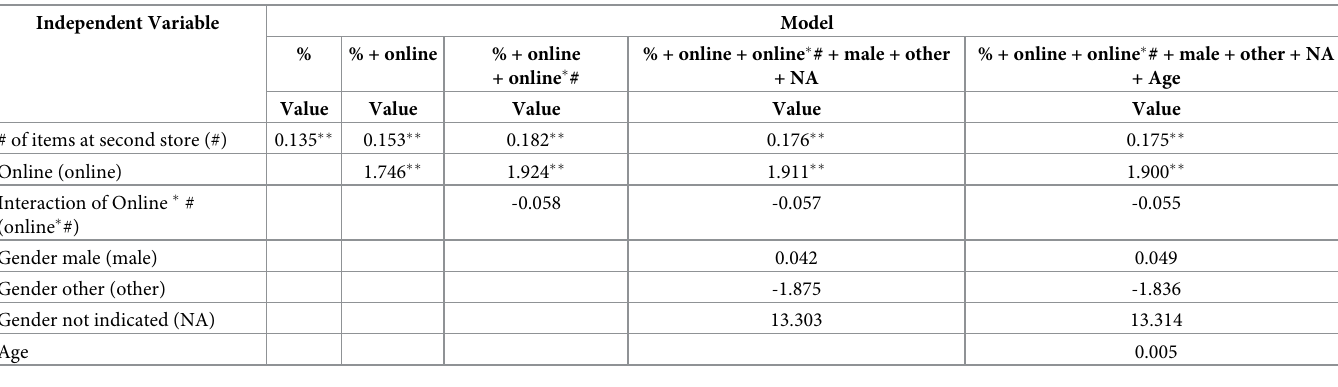
Table 14. Ordered logistic results against likelihood (n = 464) (Study 3).